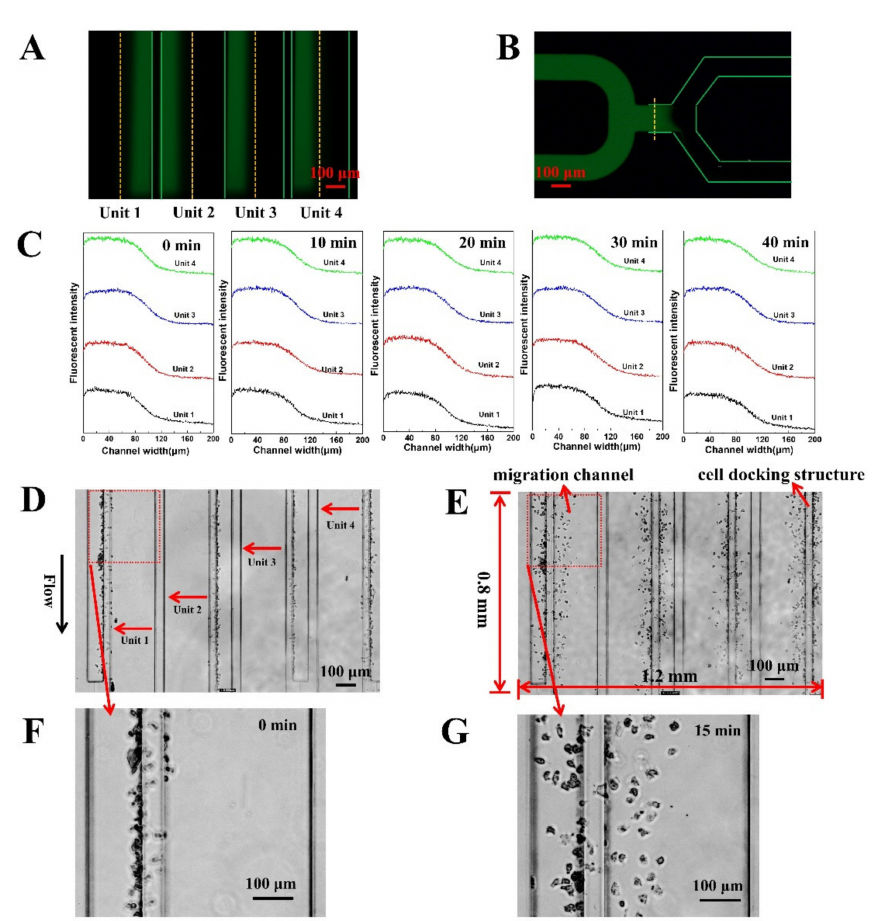
Figure 3. F4-chip characterization. ( A ) Fluorescent images in the four main channels; ( B ) Fluorescence image of the balance channel; ( C ) Gradient curves in unit 1, 2, 3, and 4 at 0 min, 10 min, 20 min, 30 min, 40 min; ( D ) Images of cell distribution beside cell docking structure; ( E ) Images of cell distribution in the migration channel after gradient application. Neutrophils need to deform and squeeze through the cell docking structure before migration into the migration channels; ( F ) An enlarged image for tracking analysis (0 min); ( G ) An enlarged image for tracking analysis (15